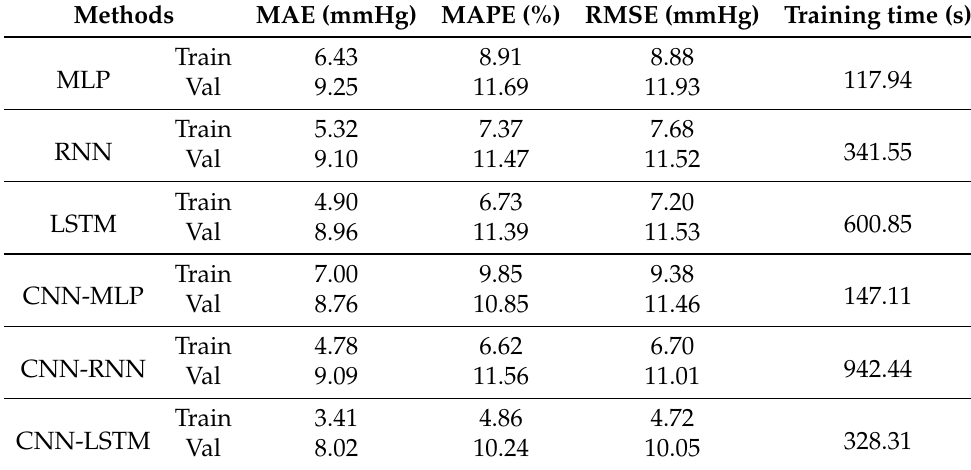
Table 5. Predicted performance of patient